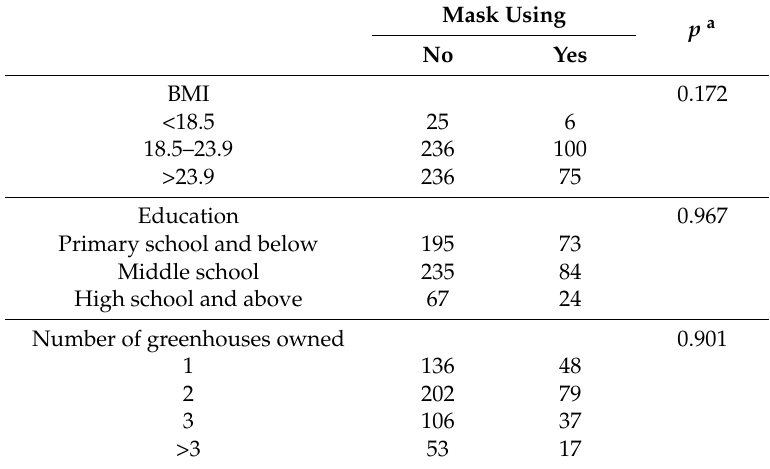
Table A4. Relationship between mask using and possible influence